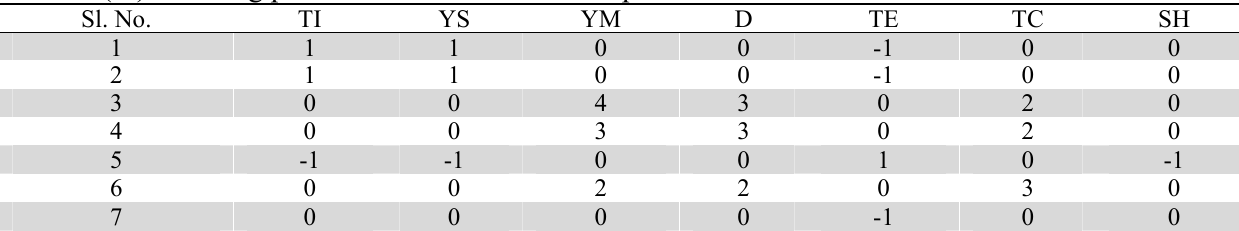
Matrix ( S 8 ) at slicing parameter θ 8 = 0.80 for example 2 Sl. No.